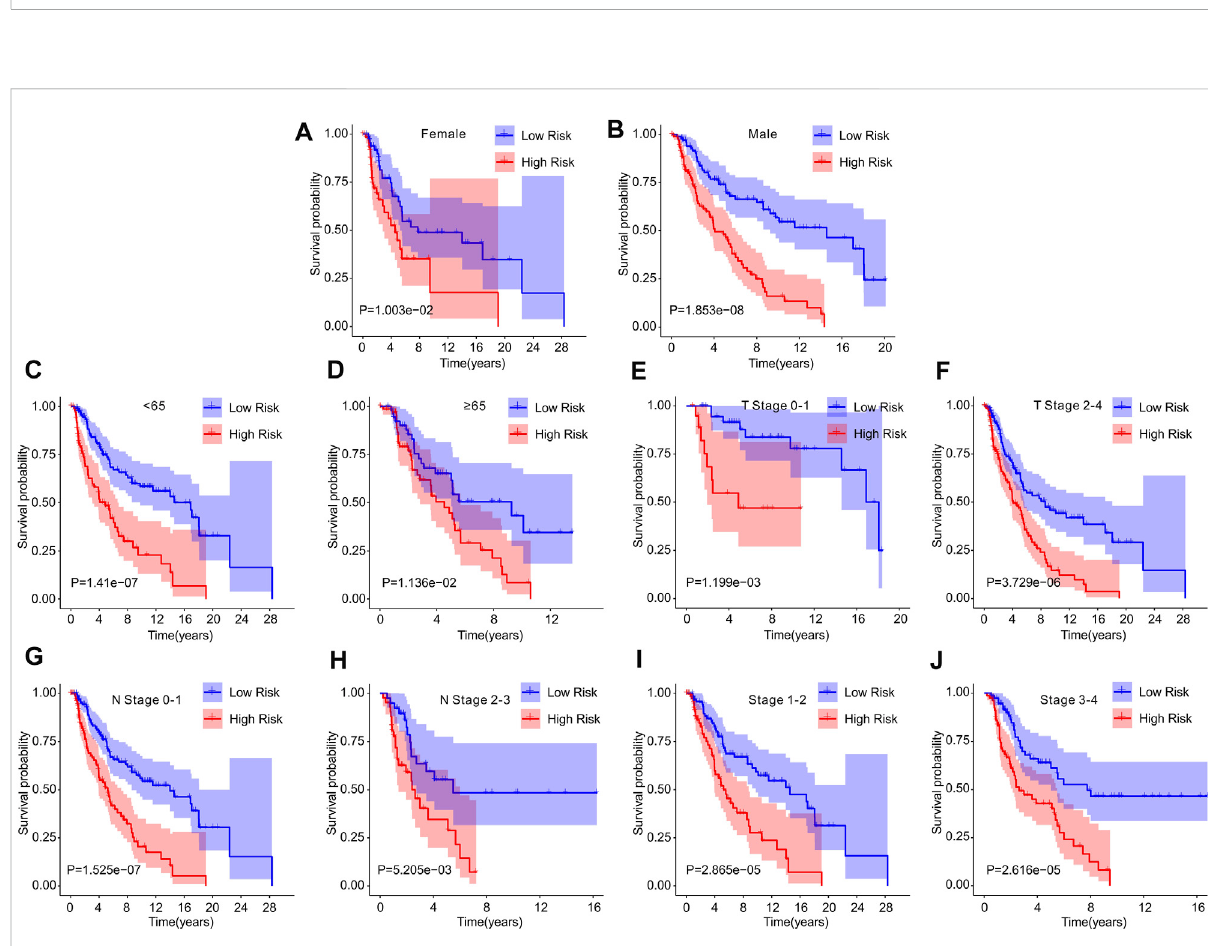
FIGURE 4 The Kaplan-Meier survival curve of patients in low- and high-risk groups strati fi ed by different clinicopathological characteristics. The survival curveshowedtheoverallsurvivalrateofpatientsinlow-and high-riskgroupsstrati fi edby (A,B) gender(female vsmale), (C,D) age( < 65vs ≥ 65), (E,F) T stage (T 0-1 vs T 2-4), (G,H) N stage (N 0-1 vs N 2-3), (I,J) stage (stage 1-2 vs stage